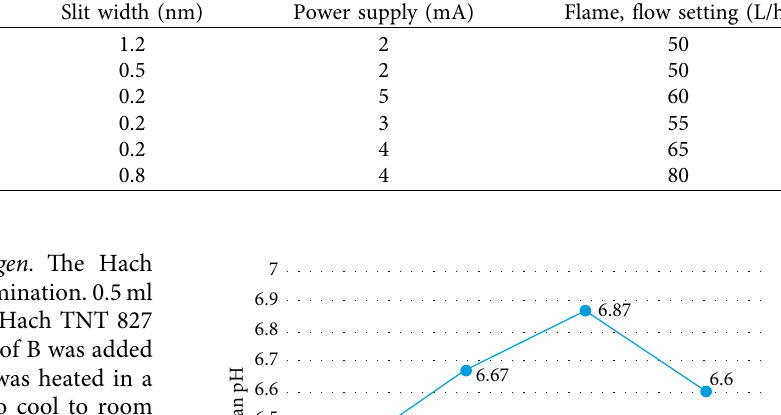
Table 2: The instrumental conditions for the measurement of all the elements to be determined in the samples. Element